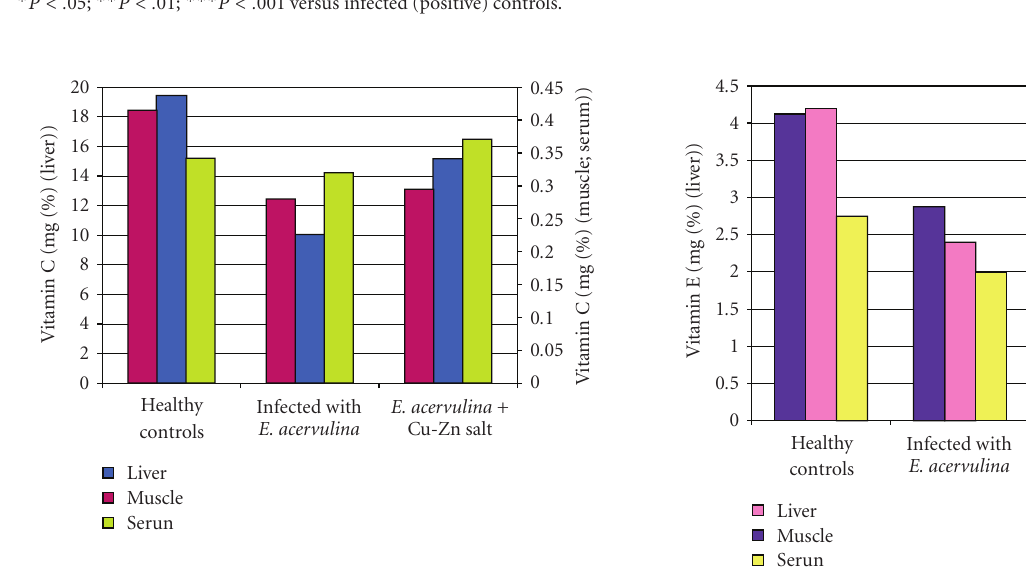
Figure 4: Content of vitamin C in broiler chickens. Figure 5: Content of vitamin E in broiler